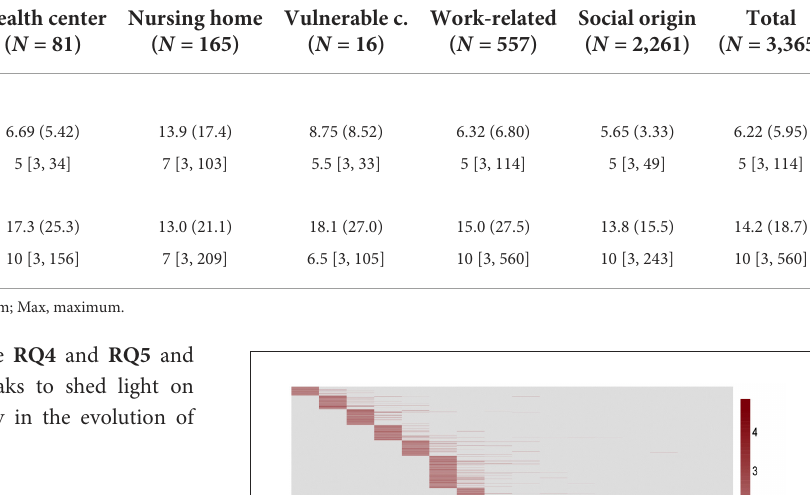
TABLE 1 Descriptive statistics of the outbreaks per origin of the infection.